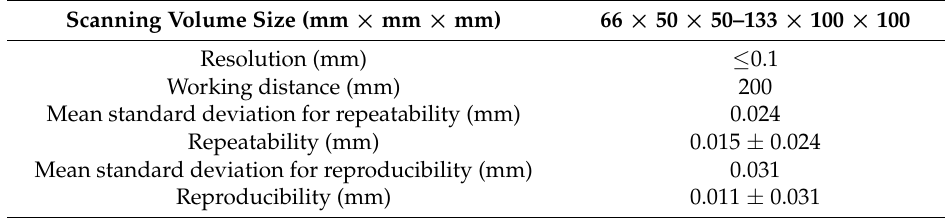
Table 2. The results of the second experimental campaign.